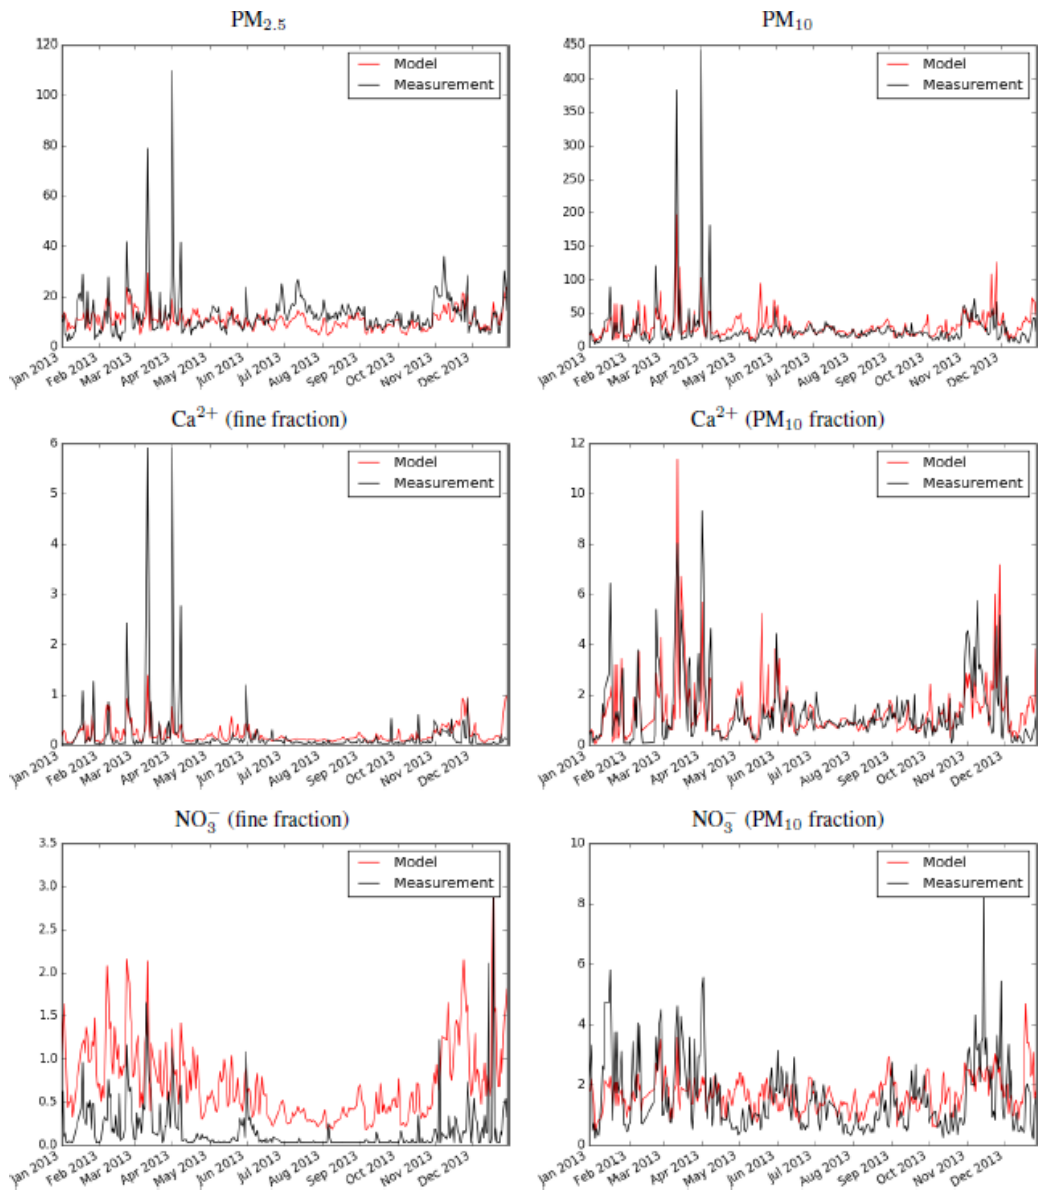
Figure 13. Modeled (red) and measured (black) concentrations of PM 2 . 5 , PM 10 , Ca 2 + (fine fraction and PM 10 fraction) and NO − fraction and PM 10 fraction) in µgm − 3 for the Cyprus station